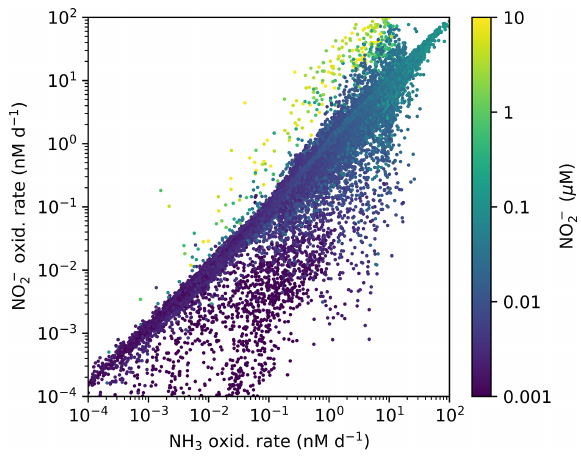
Figure A1. Annually averaged aerobic NO − oxidation rate against 2 NH 3 oxidation rate with associated local concentration of NO − 2 in the global ecosystem model (Darwin-MITgcm). The locations where NO − oxidation exceeds NH 3 oxidation correspond to the 2 anoxic zone locations where NO − has accumulated due to anaer- 2 obic NO − reduction. Physical transport combines NO − and O 2 . 3 2 See Zakem et al. (2019) for details of anaerobic functional type pa-